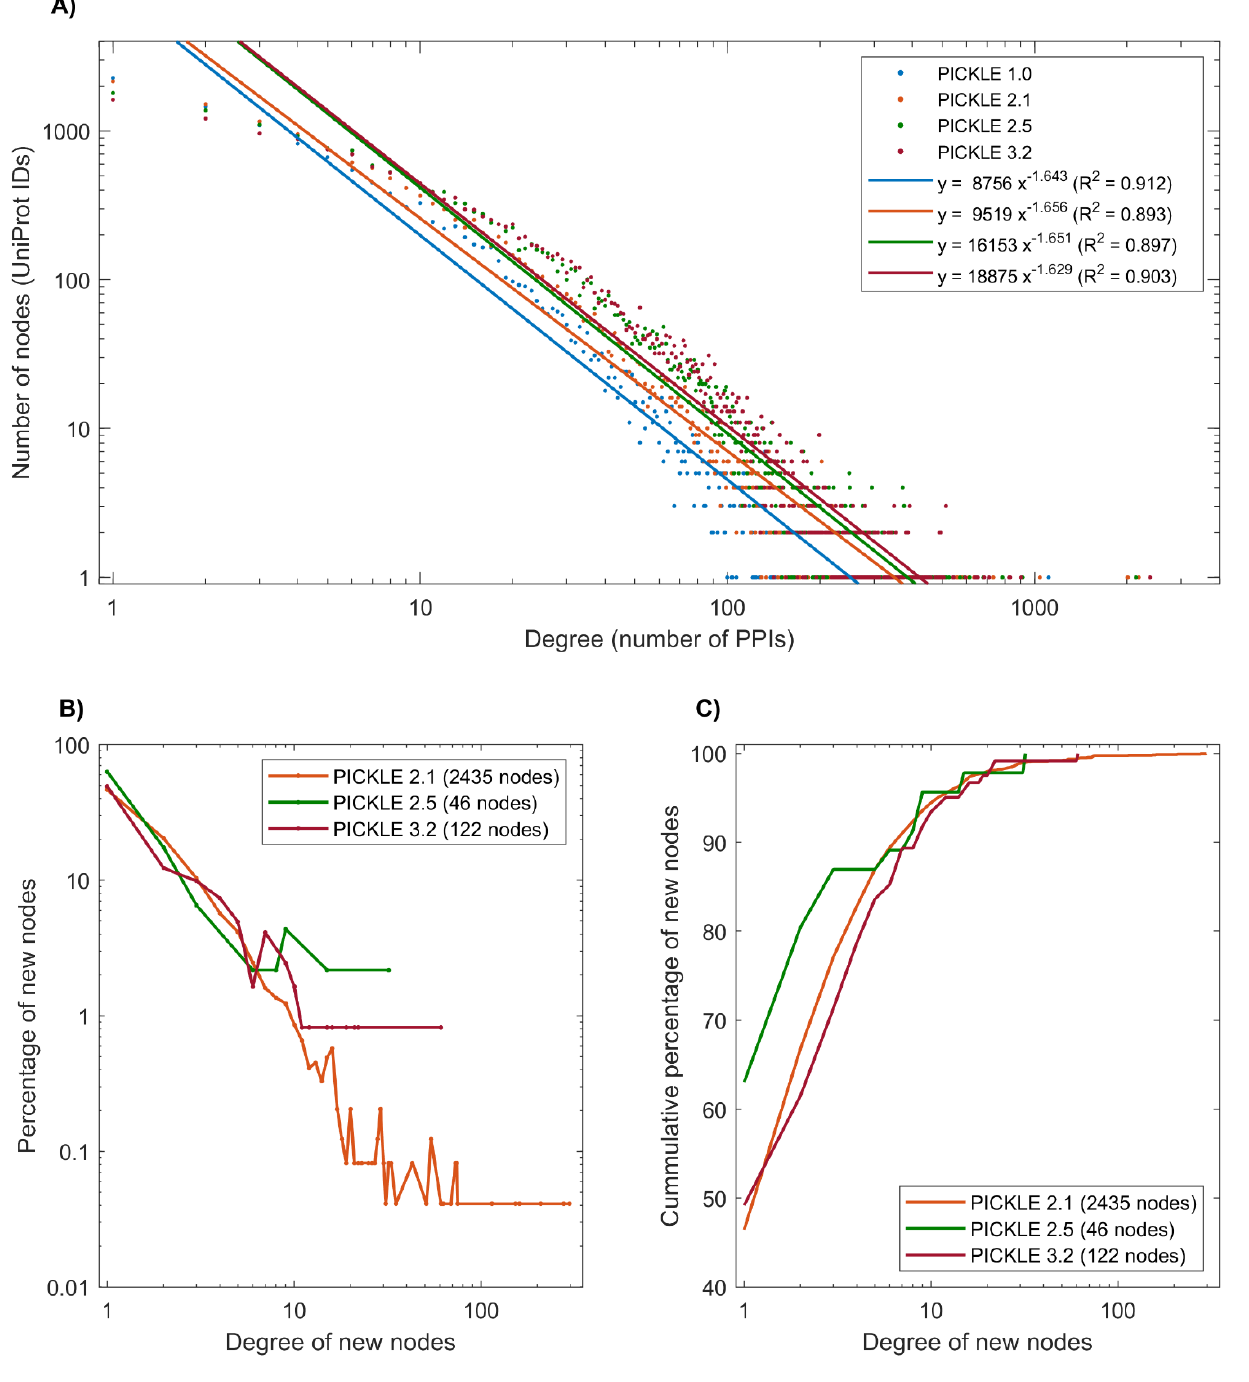
Figure 2 . Network analysis of the human protein interactome. ( A ) The degree distribution of the network throughout PICKLE releases, following the power law. ( B ) The degree distribution and ( C ) The cumulative degree distribution for the newly inserted proteins in representative PICKLE releases. The majority of new nodes have a degree lower than 5, while none are considered as a hub, since the maximum degree is less than 300.